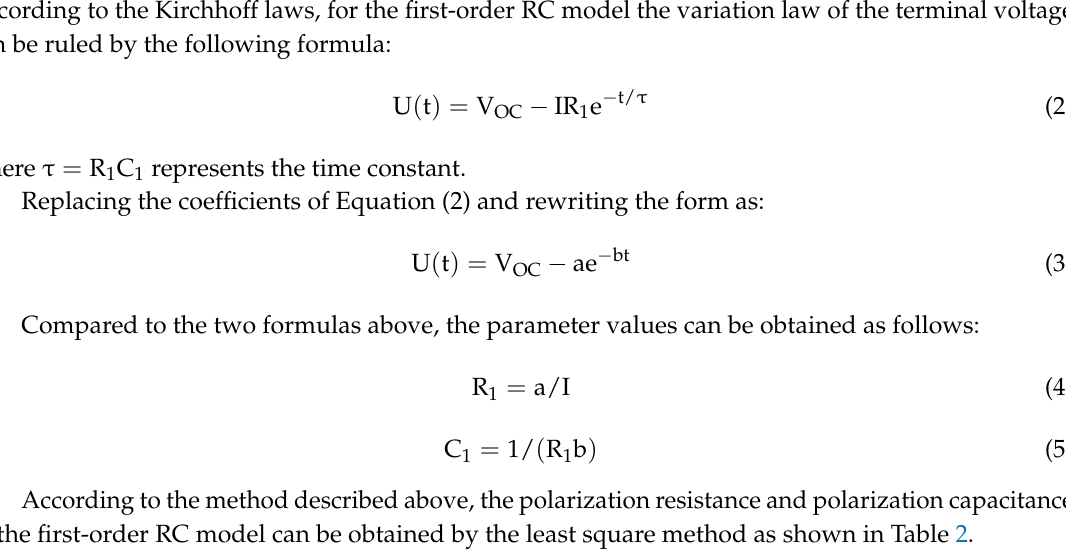
Table 2. Polarization resistance and polarization capacitance values of lithium-ion batteries for the first-order RC model.